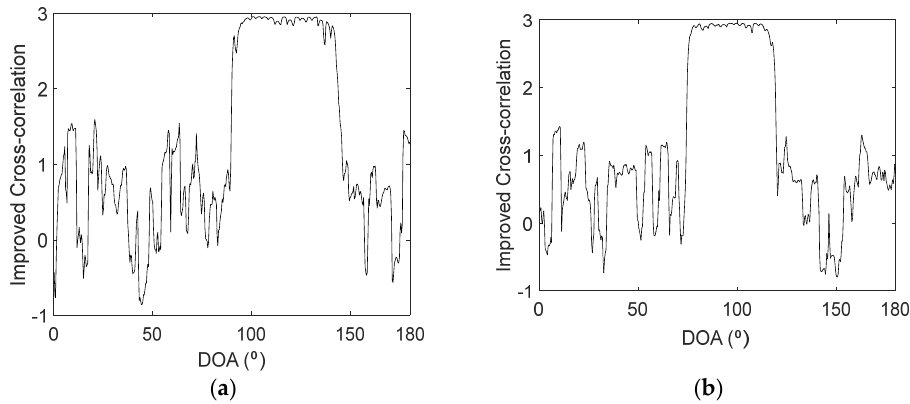
Figure 21. The DOA estimation using the proposed method indoors at distances of ( a ) 5 m and ( b ) 10 m.